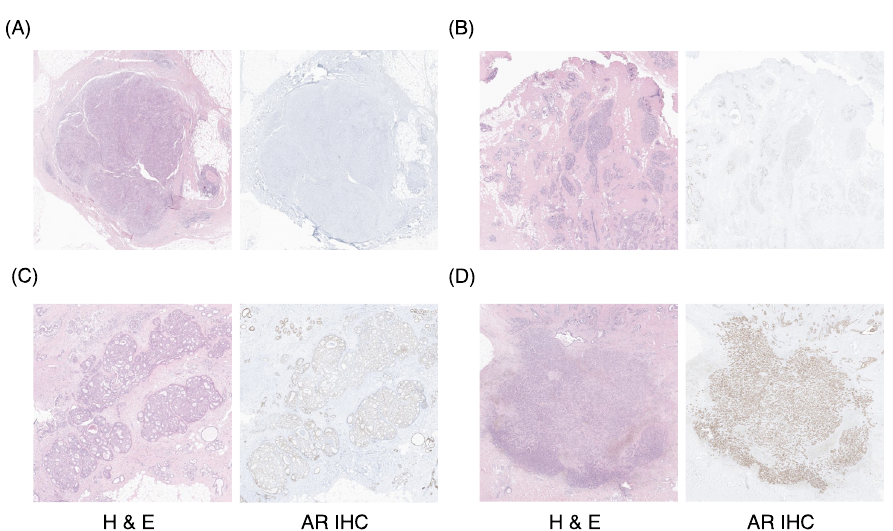
Fig 1. Representative immunohistochemistry images of AR expression. (A) AR expression < 1%, (B) 3%, (C) 65%, (D)